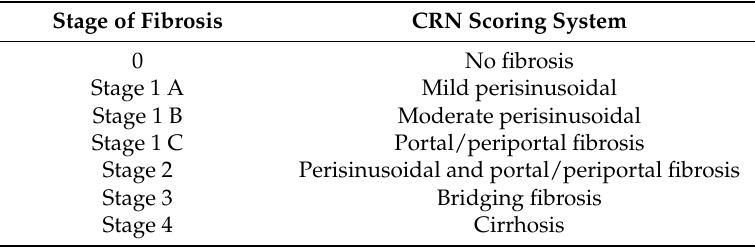
Table 5. CRN histological scoring system for grading of fibrosis in NAFLD